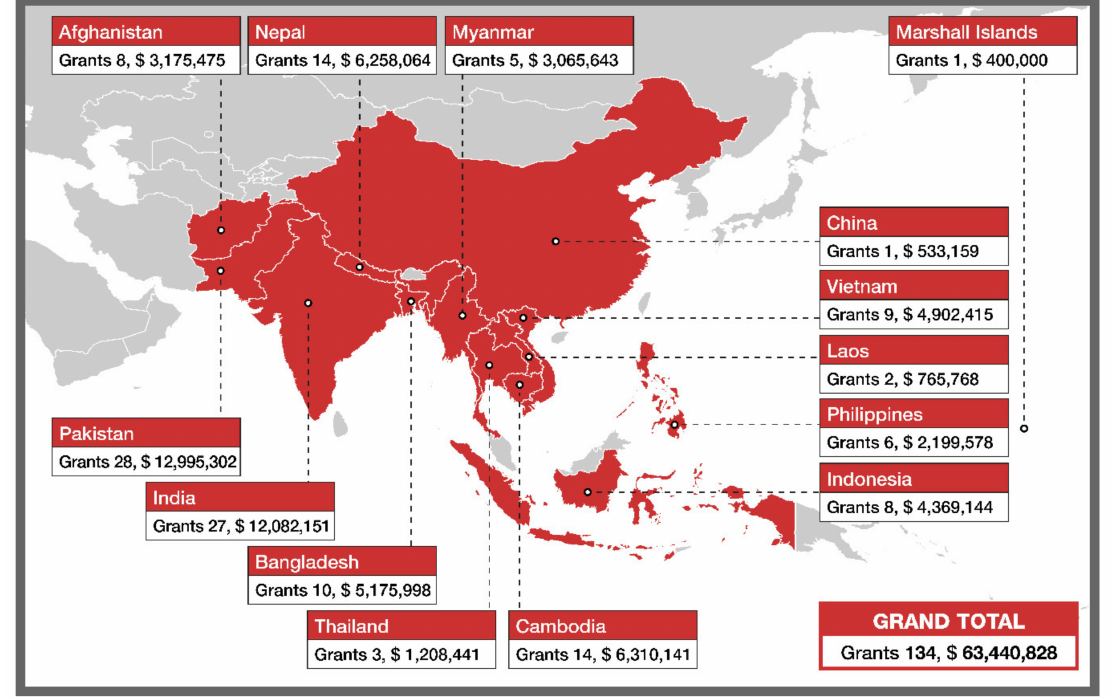
Figure 1. Map of TB REACH grants in the Asia-Pacific